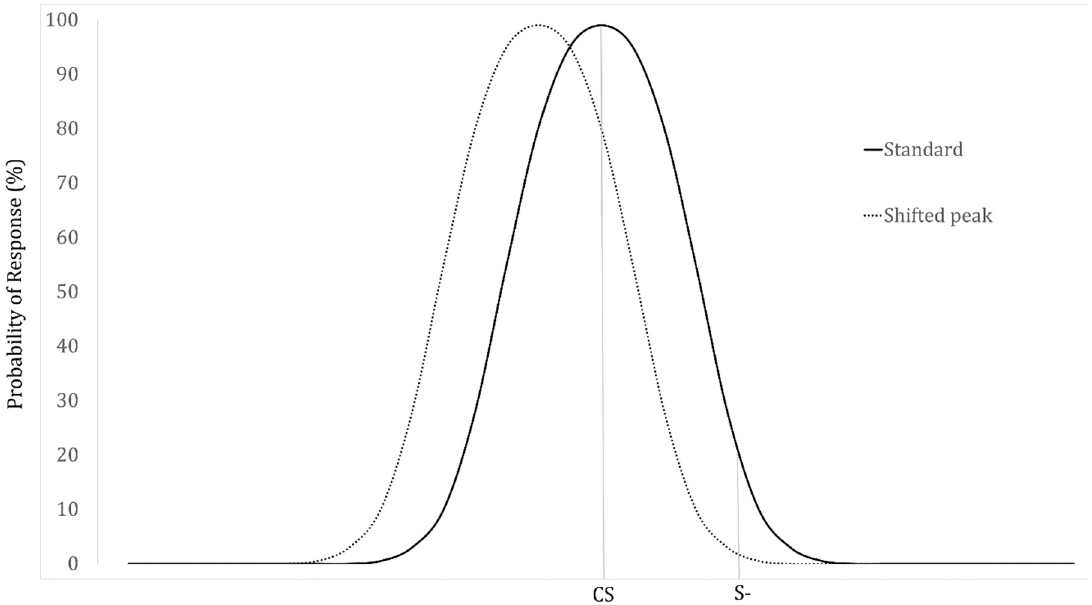
Figure 2. Theoretical peak shift of a generalization gradient. The gradient is shifted away from the negative stimulus (S-) so that fewer responses are made towards it. In the shifted peak, the highest rate of responding is no longer to the conditioned stimulus (CS).